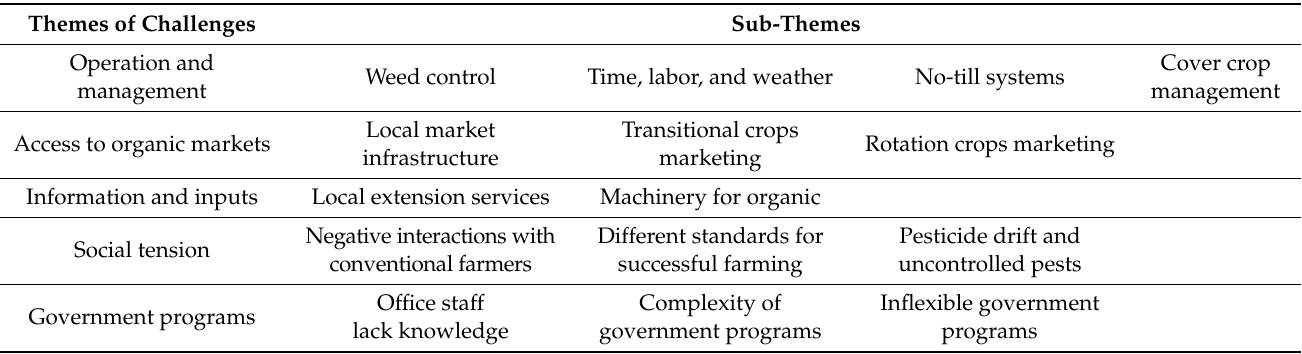
Table 3. Themes and Sub-themes of Challenges of Organic Grain Farming